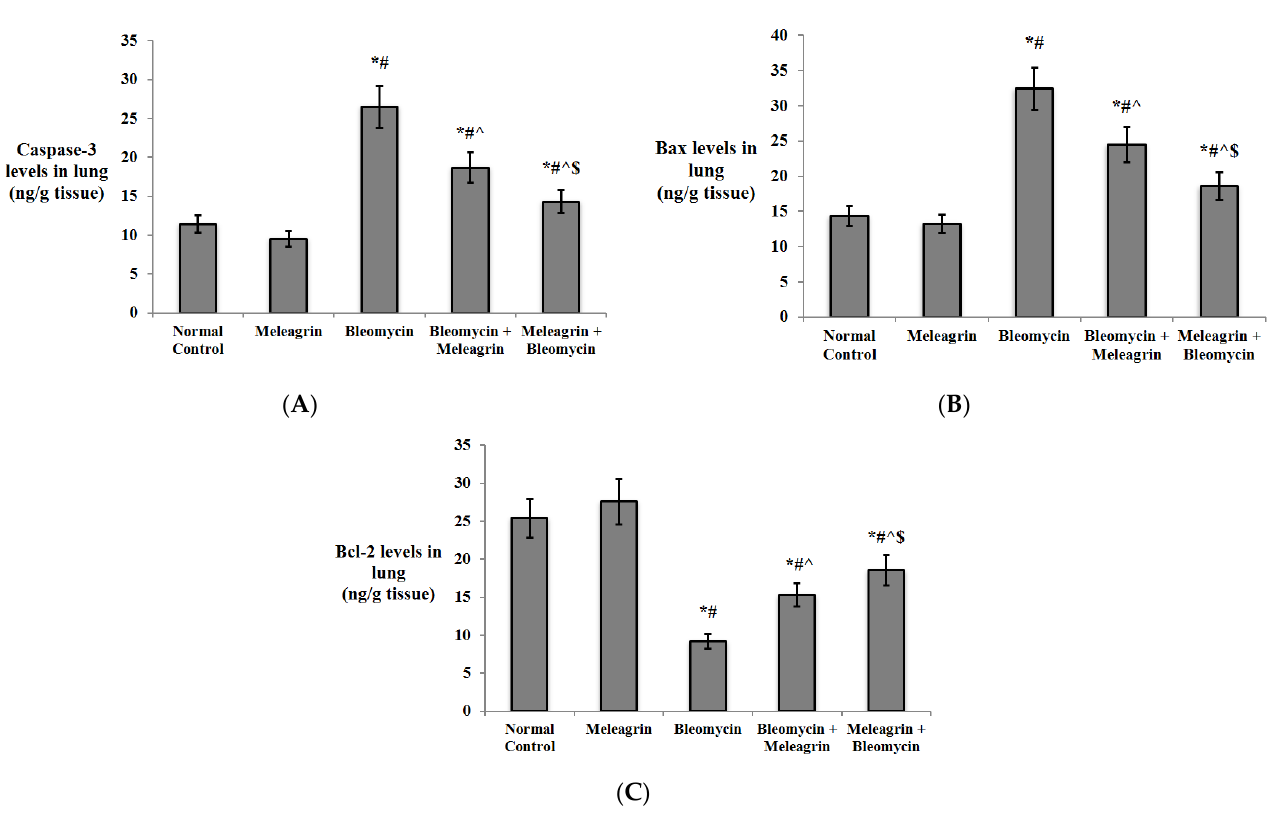
Figure 9. The effect of meleagrin on the protein levels of markers of apoptosis ( A ) caspase-3, (B) Bax, and ( C ) Bcl-2 in the lung tissue of the experimental mice. Bcl-2 = B cell lymphoma-2; Bax = Bcl-2 associated x. Data are expressed as mean ± SD and analyzed using one-way ANOVA followed by Bonferroni’s post hoc test ( n = 8). * significantly different vs. the normal control group; # significantly different vs. the meleagrin group; ^ significantly different vs. the bleomycin group; $ significantly different vs. the bleomycin + meleagrin group. Differences were considered significant at p < 0.05.